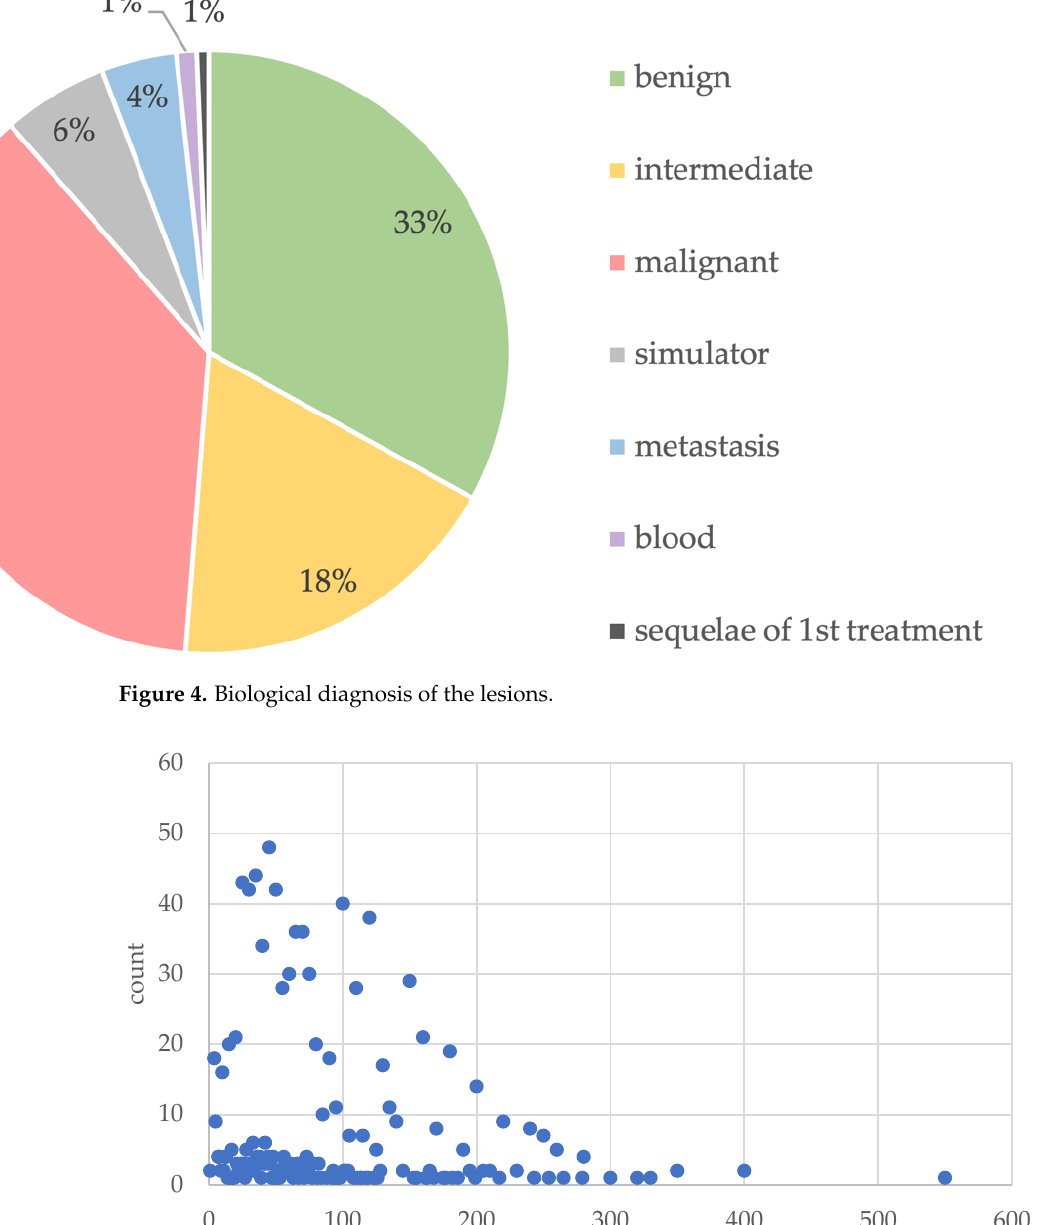
Figure 5. This diagram shows the number and size of the tumors.